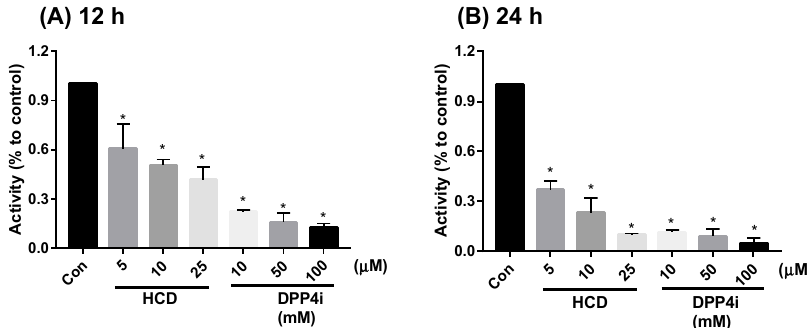
Figure 2. Alteration of Caco-2 - bound DPP-4 activity by docked natural compounds . 16- hydroxycleroda-3,13-dien-15,16-olide (HCD) and sitagliptin (DPP4i) were treated with differentiated Caco-2 for ( A ) 12 h and ( B ) 24 h and DPP-4 activity determined . All data were converted into a ratio with the untreated control and shown as mean ± SD from three independent experiments . * p < 0.05 was marked in the column significantly different with Con .